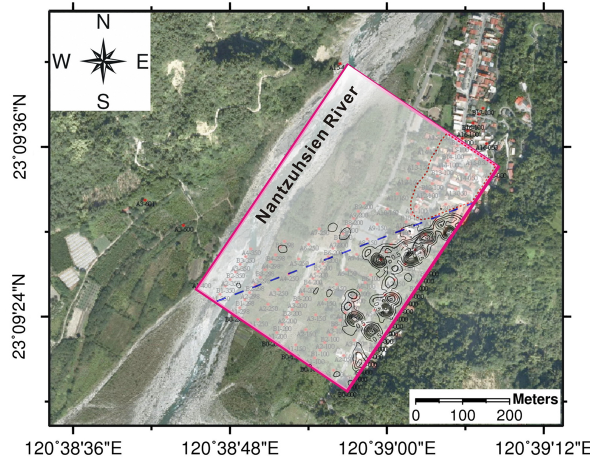
Fig. 6. Superposing the distributions of the first-order analytic sig- nals (contours) onto an aerial photograph taken before Typhoon Morakot. The thick dashed line indicates the destruction frontier of the landslide suggested by the magnetic survey. Buildings in the area encircled by the red dotted curve were destroyed and removed by the landslide